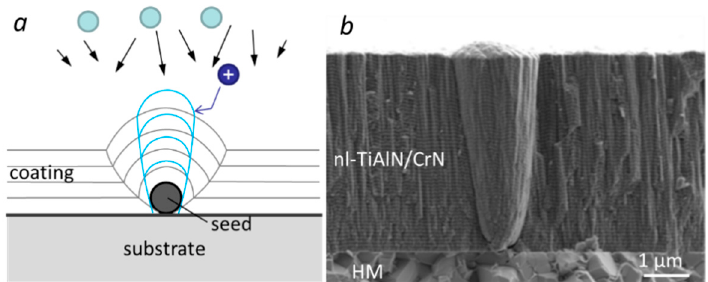
Figure 10. Scheme of a conical and parabolic nodule cross-section; the shape mainly depends on the flux distribution of the incoming atoms ( a ); fracture cross-section SEM image of a typical nodular defect with rather straight vertical walls in the nl-TiAlN/CrN hard coating prepared by magnetron sputtering ( b ).